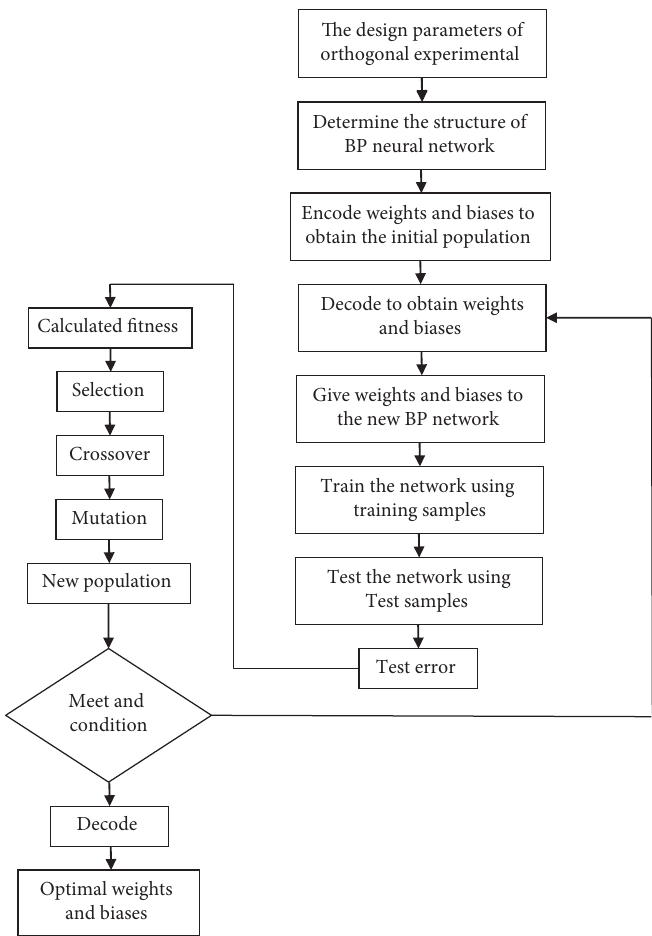
Figure 4: Flow chart of the BP neural network optimized by genetic algorithm. Table 5: Comparison between the experimental data of the compressive strength and expansion rate of the FSSAC with the predicted results. Mechanical property